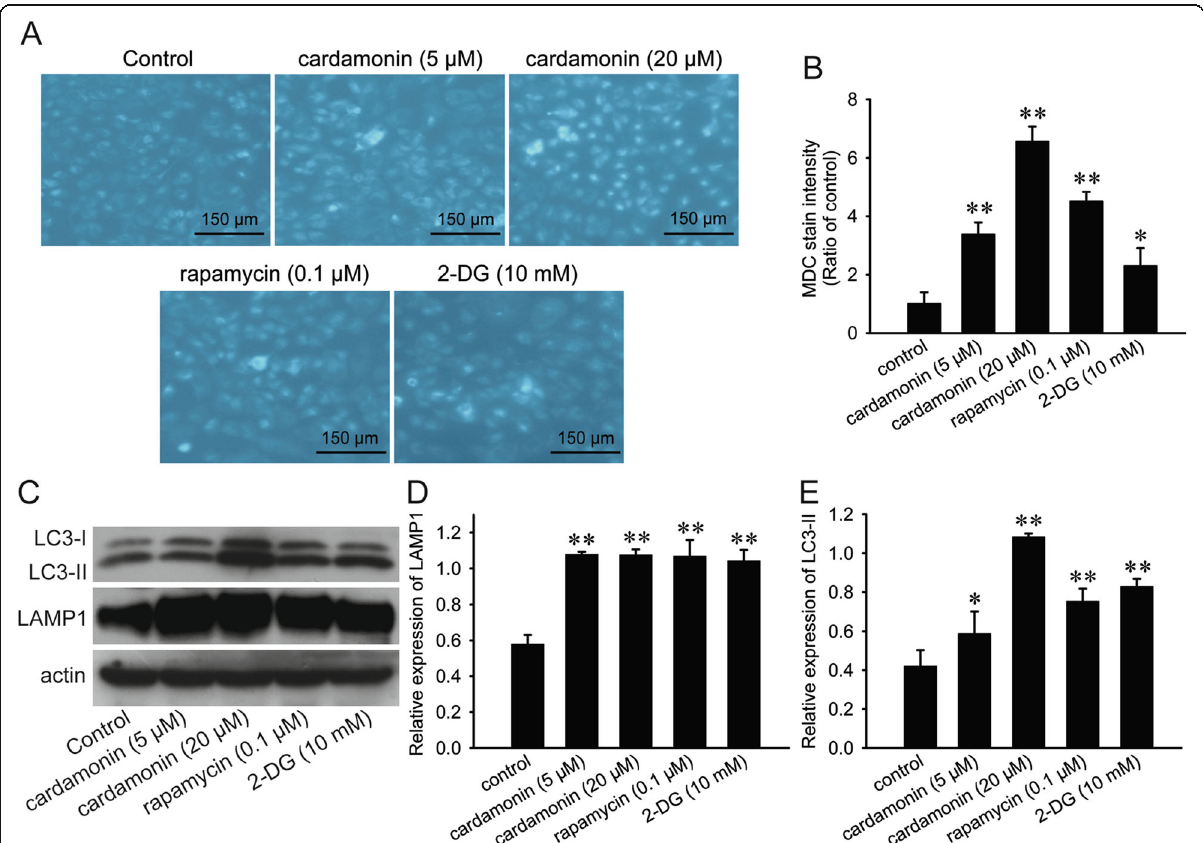
Fig. 2 Cardamonin induced cell autophagy. SKOV3 cells were treated with cardamonin (5, 20 μ M), rapamycin (0.1 μ M) and 2-DG (10 mM) for 48 h, respectively. a MDC stain was applied to detect the level of autophagy. b The quantitative results of fluorescent intensity. c Expression of LC3 and LAMP1 was detected by Western blot. d , e Quantification of LC3-II and LAMP1 by densitometry of Western blot performed above. * p < 0.05, ** p < 0.01 vs. control. Data were represented as mean ± SD, n =